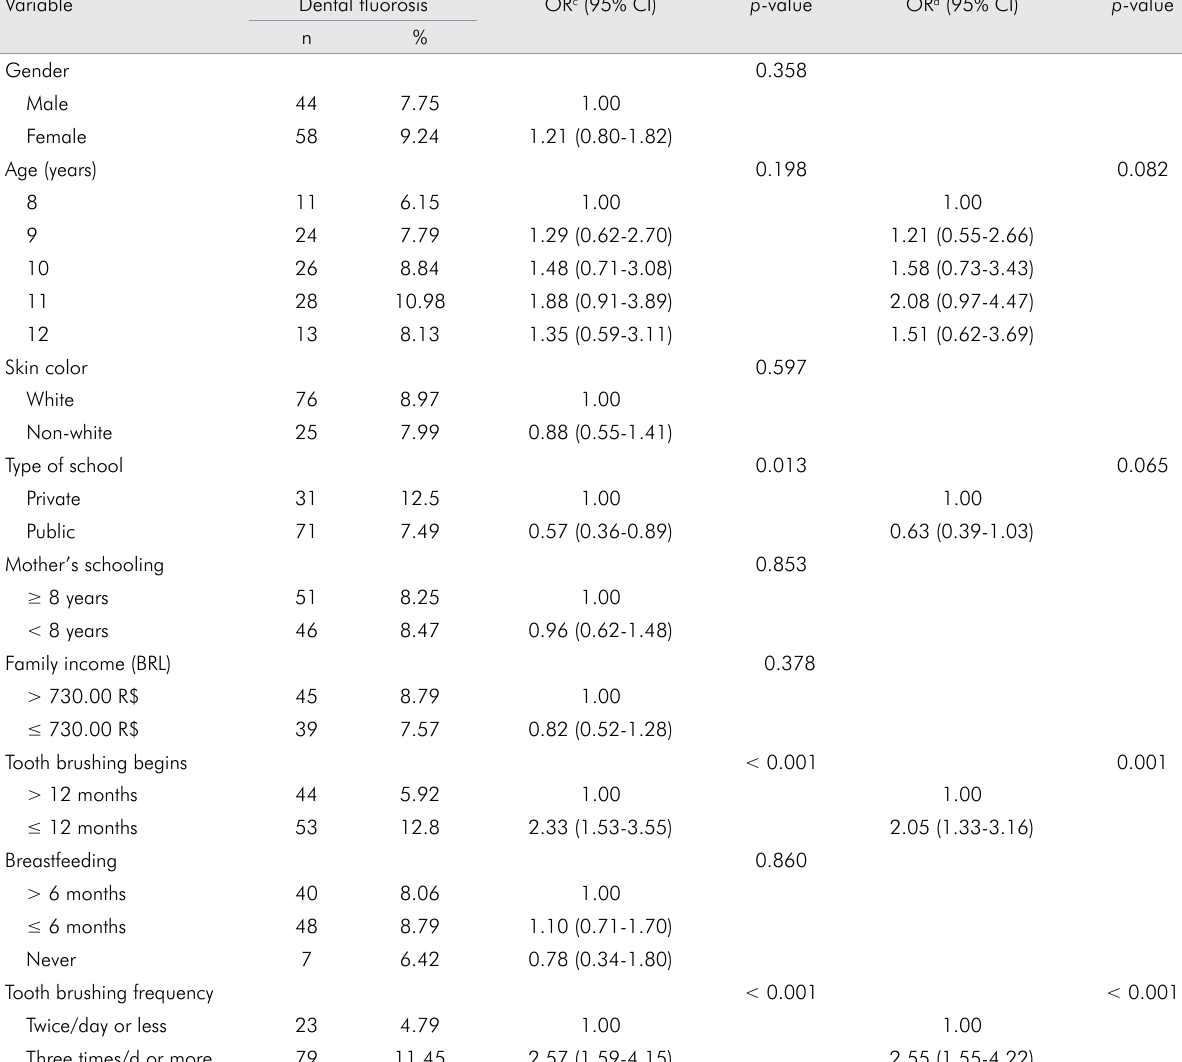
Table 2. Unadjusted and adjusted logistic regression models for prevalence of dental fluorosis among 8- to 12-year-old chil- dren. Pelotas/2010 (n =